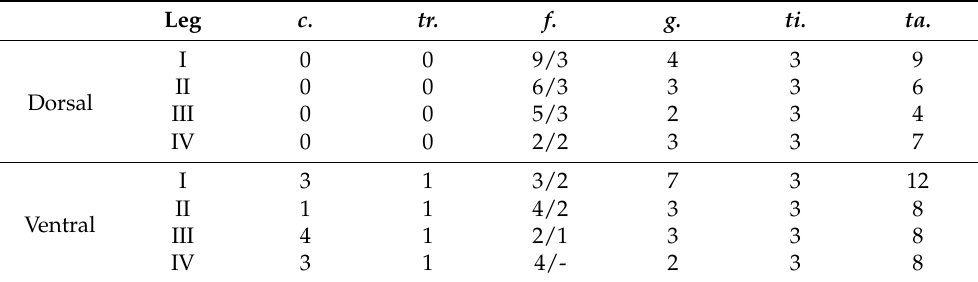
Table 3. Chaetotaxy of S. nunatakis legs. Dorsal and ventral refer to surfaces of the leg segments; chaetotaxy in the femur shown as basal/apical segment; solenidia are excluded from the count, whereas trichobothria are included (see Figure 7 for the details and position leg chaetotaxy). c. coxa, tr. trochanter, f. femur, g. genu, ti. tibia and ta. tarsus. Leg c. tr. f. g. ti. ta. I 0 0 9/3 4 3 9 II 0 Dorsal IV 0 0 2/2 I 3 1 Ventral